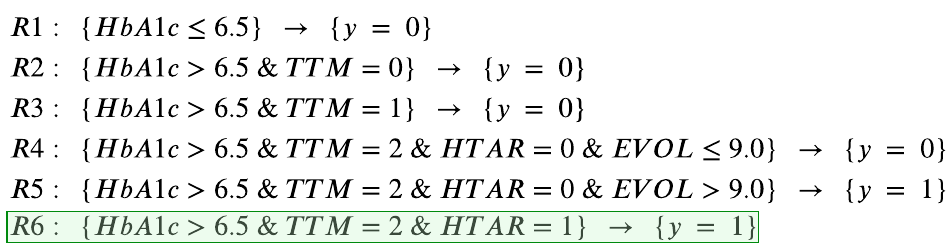
Figure 3. The constructed rules using the explanation system for x